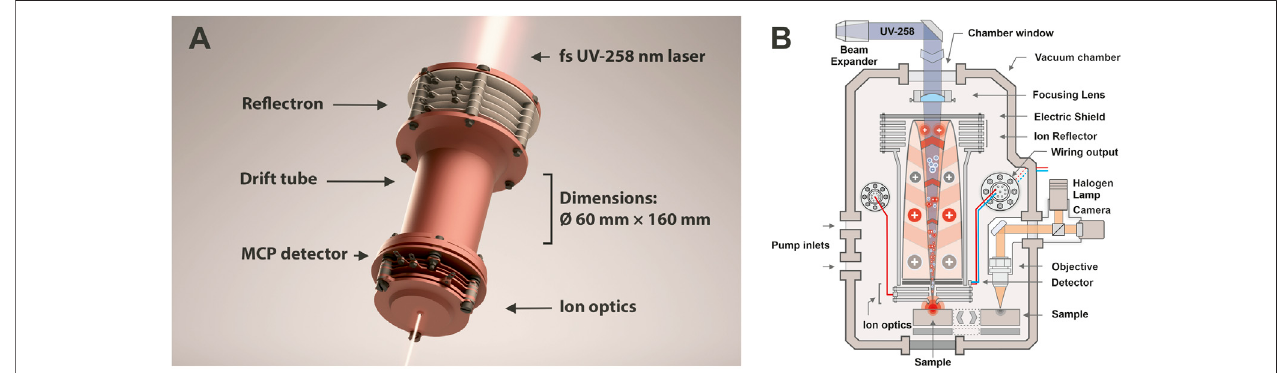
FIGURE1 |(A) 3D render of ourminiature time-of- fl ight mass analyzer. Locationof there fl ectron, drift tube, entrance ion optics,MCP detector, and dimensionsof theinstrumentaredenoted.Thefocusingfs-UVlaserlightshownonthetopandthebottomandillustratesanaxialdesignofthemassanalyzer.Samplepositioningisnot shown.However, inthelaboratory setting, theinvestigatedsampleispositionedinclosevicinitytotheentranceplate oftheionoptical systemofthemassanalyzer,right inthepositionofthelaserfocus,toachieveablationandsubsequentionizationoftargetmaterial. (B) Schematicillustrationofthefs-LIMS.Anfs-laserradiation(blue line) ablates and ionizes material from the sample. The positively charged ions are separated and detected using the time-of- fl ight mass spectrometer. The ablation position can be precisely located using an integrated microscopy system.